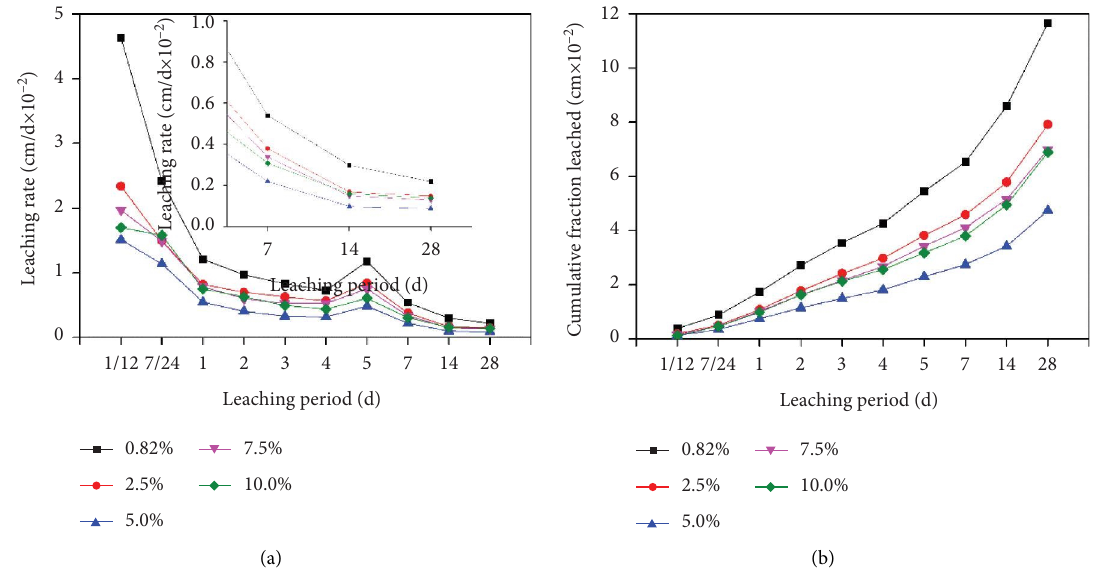
Figure 19: Te leaching curves of Sr 2+ in the SFCM with diferent sodium hydroxide contents at a sodium nitrate concentration of 300g/L: (a) LF; (b)